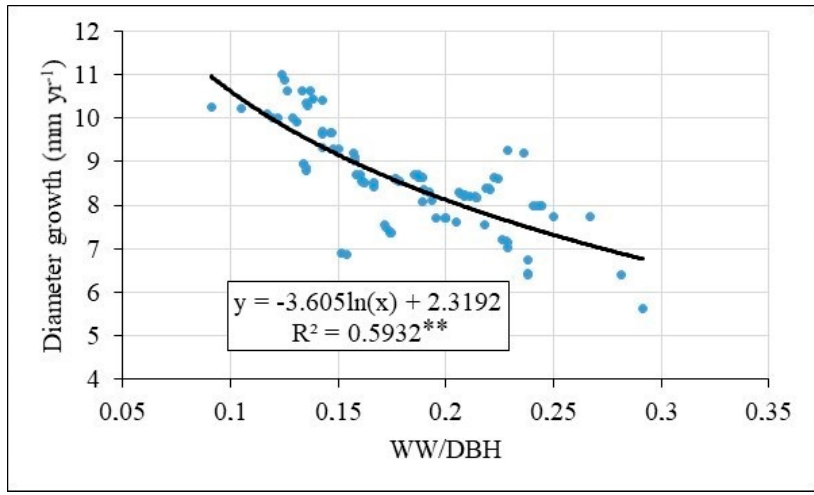
Figure 10. Wounded diameter growth in relation to the ratio of wound width to dbh. ANCOVA results indicated interactions between dbh and WI, dbh and WH, dbh and WW; WI and WS, WI and WH, WS and WH had significant effects on both WWHR and DG, while the interaction between WW and WH had no significant effect on either WWHR and DG. The interaction between dbh and WS had significant effects only on DG (Table 7). Table 7. ANCOVA results for the interaction of independent variables on wound width healing rate (WWHR) and diameter growth (DG) of loblolly pine stems; dbh: diameter at breast height, 1.30 m; WI: wound intensity; WS: wound size; WH: wound height; WW: wound width. Variables